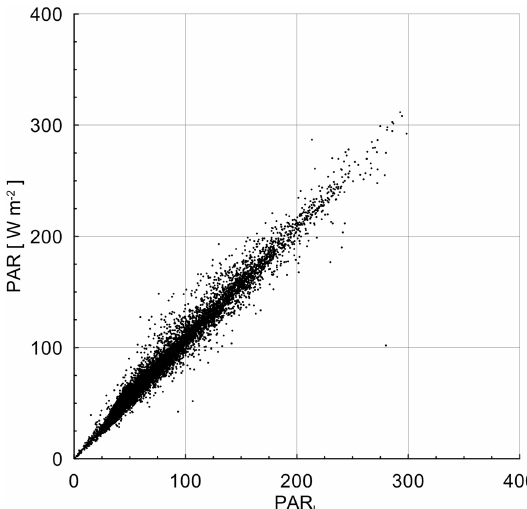
Figure 1. Scatterplot between 5min averages of PAR and PAR L for the period 19 February–25 May 2016 at Lampedusa. The linear fit is also shown.